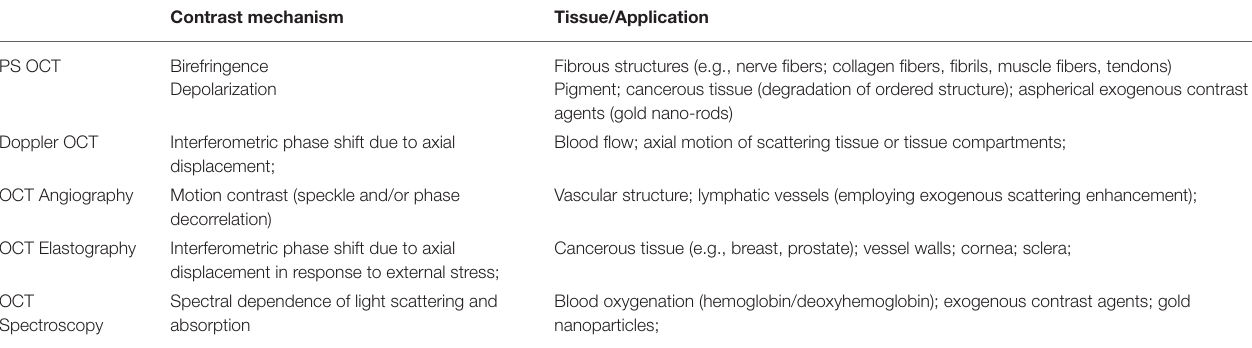
TABLE 1 | Functional OCT extensions, their contrast mechanisms, and applications. Contrast